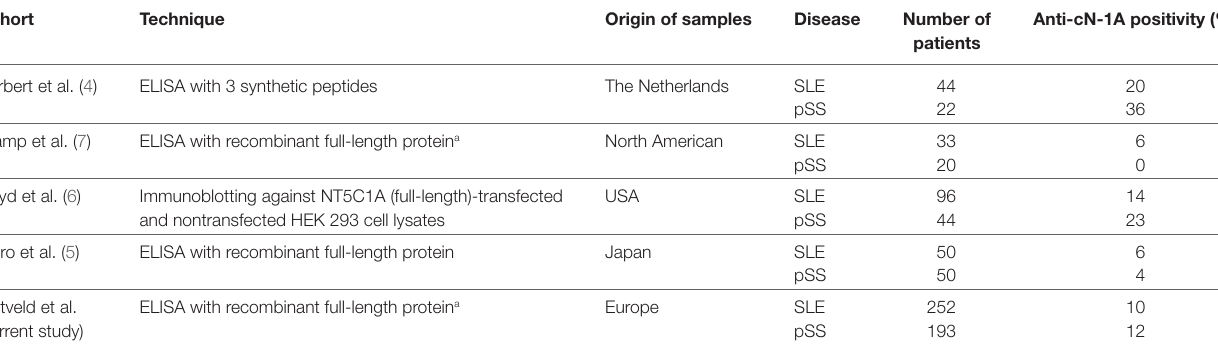
Table 3 | Anti-cN-1A reactivity among systemic lupus erythematosus (SLE) and primary Sjögren’s syndrome (pSS) cohorts in former and current studies. cohort Technique Origin of samples Disease number of